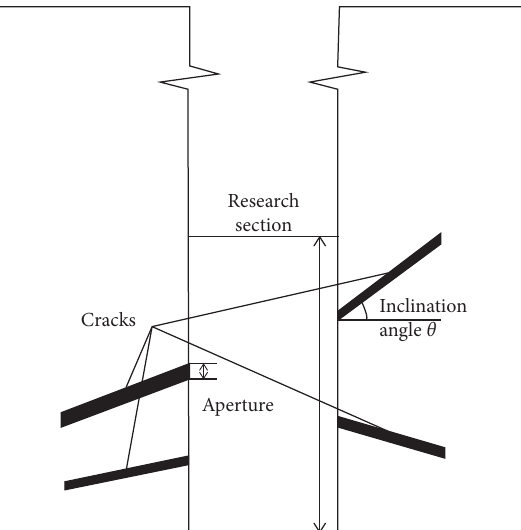
Figure 2: Schematic map of fracture distribution during the borehole hydraulic pressure